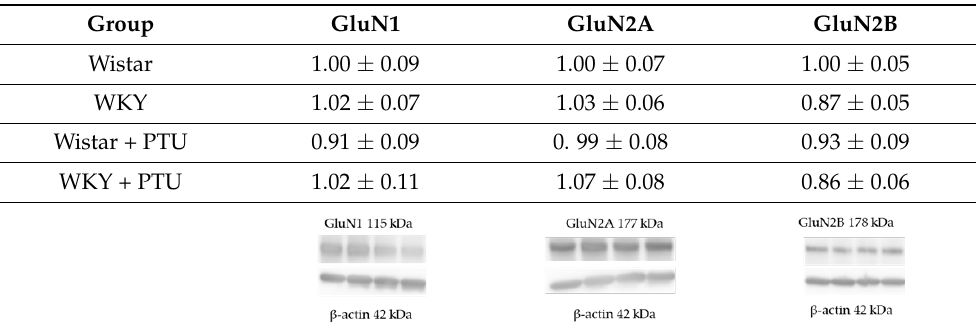
Table 5. The effects of strain and PTU treatment on the protein levels of subunits of NMDA receptor (GluN1, GluN2A, GluN2B) in the hippocampus. The results are expressed as the average fold change ± SEM. n = 7–10.